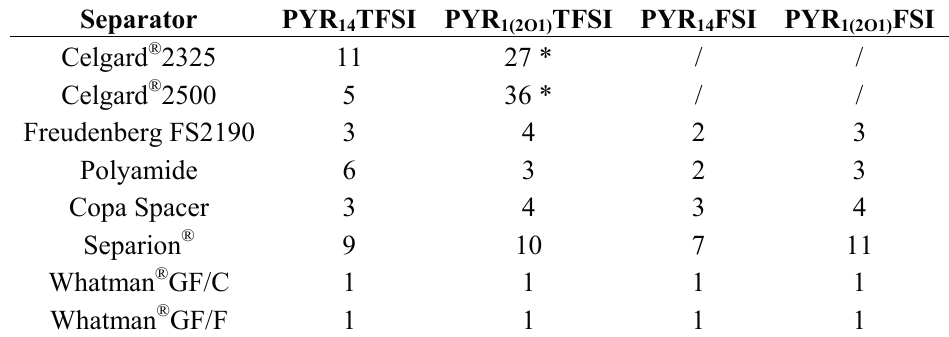
Table 2. Calculated McMullin numbers ( N m) for 0.1 mol % LiTFSI electrolytes.